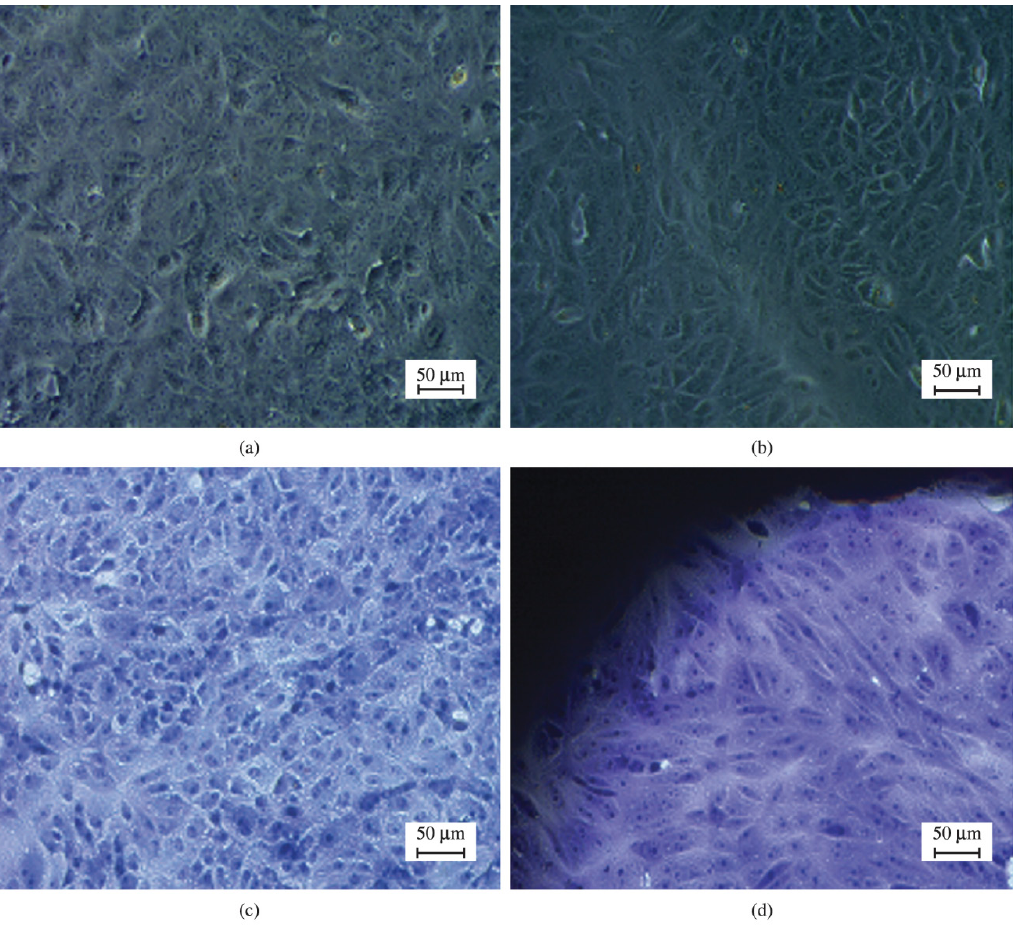
Figure 13. Test of cytotoxicity biomaterial. (a) Cytotoxicity indirect, phase contrast, (b) Direct contact of the cells with the biomaterial, phase contrast. (c) indirect cytotoxicity, cells stained with toluidine blue (d) Direct contact of the cells with biomaterials, cells stained with toluidine blue. It can be observed the cell monolayer widely scattered, with typical morphology of fibroblasts, even in the limit contact with the biomaterial gelatin / PVP. Increase: